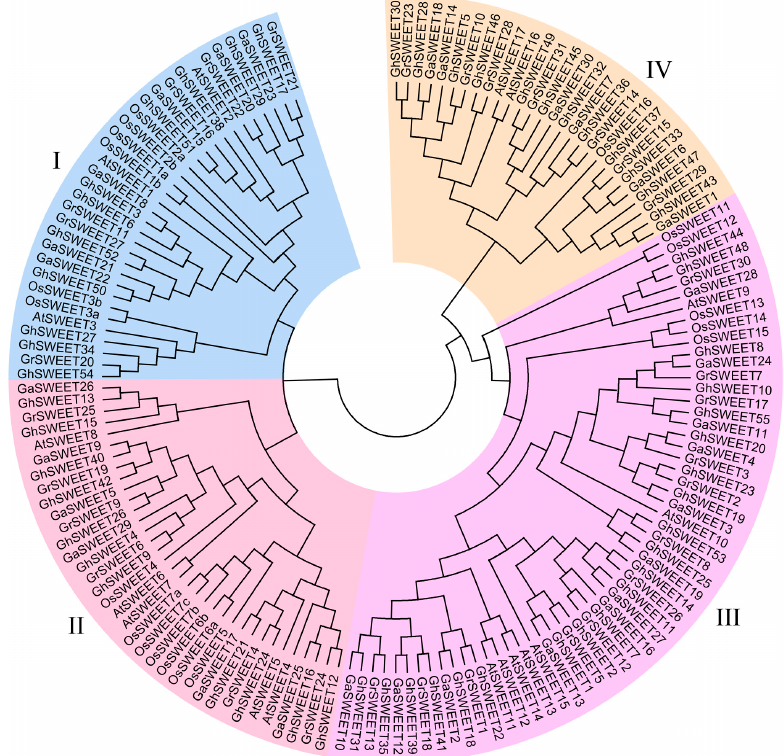
Figure 1. Neighbor-joining phylogenetic tree of SWEET genes from three cotton species, A. thaliana , and rice. The SWEET genes were classified into four clades, which are indicated by different colors.